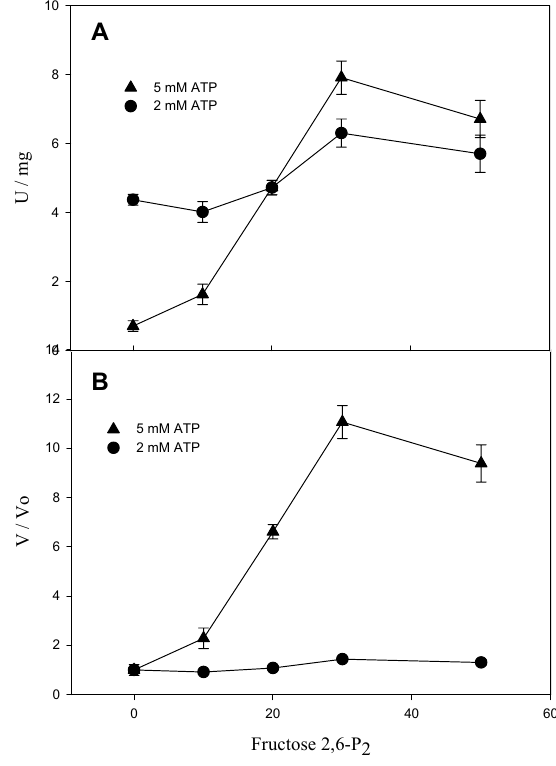
Fig. 8 – Effects of fructose 2,6-bisphosphate on PFK activity from fat body homogenate. PFK activity was measured as described on Materials and Methods, in the presence of 5 mM fructose 6-phosphate andATPasindicated. Valuesaremeans ± SEofatleastsixindependent experiments. Panel A: relative activity. Panel B: activity normalized by initial velocity (V 0 ) in the absence of the modulator.